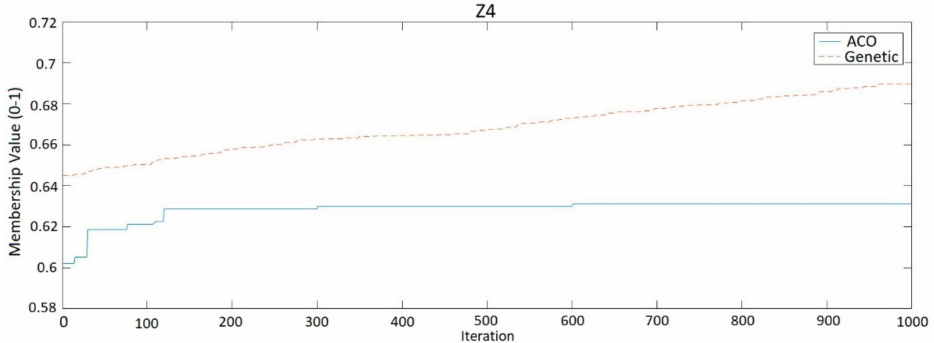
Figure 5. ( a ) Maximization process of the Z 1; ( b ) maximization process of the Z 2; and ( c ) maximization process of the Z 3.